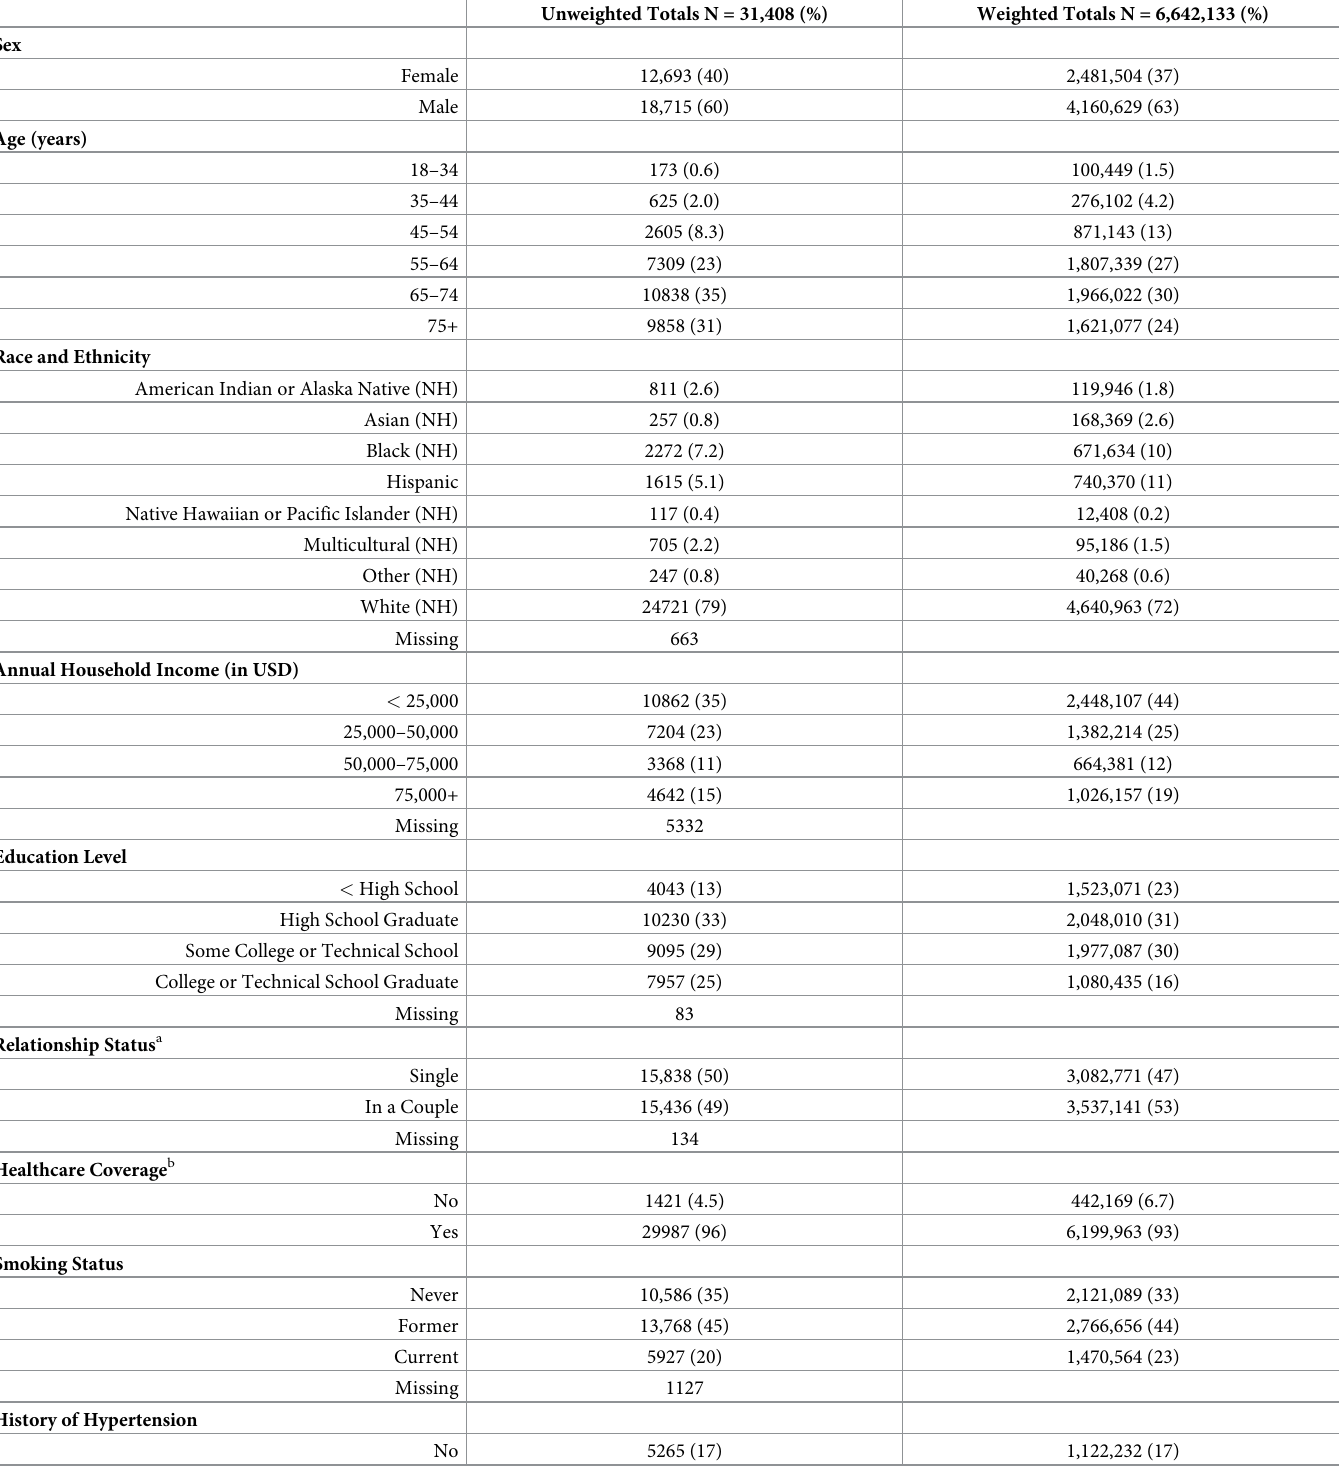
Table 1. Population characteristics among 2017 and 2019 BRFSS participants (unweighted and weighted) with self-reported history of myocardial infarction and high blood